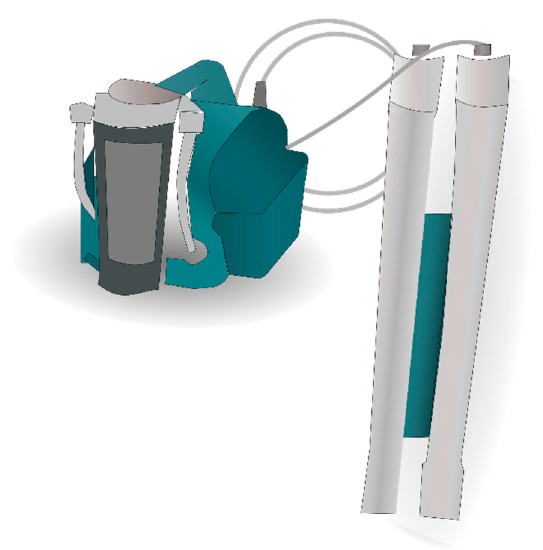
Figure 2. Sketch of the portable RO desalination system from Rainman desalination inside the elec- tric van, including the two RO membranes, the motor, and the